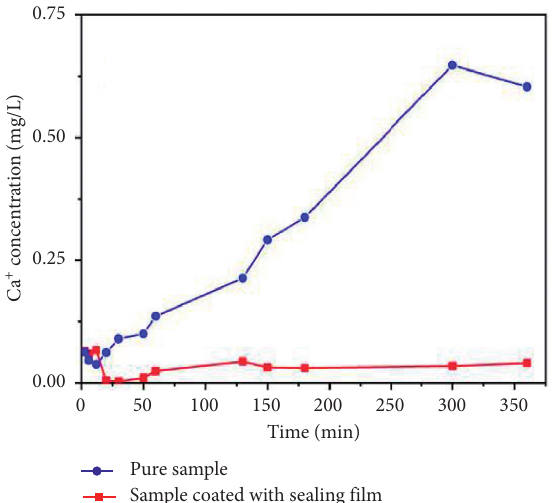
Figure 14: Plot of calcium ion concentration over time of the samples with and without sealing film.